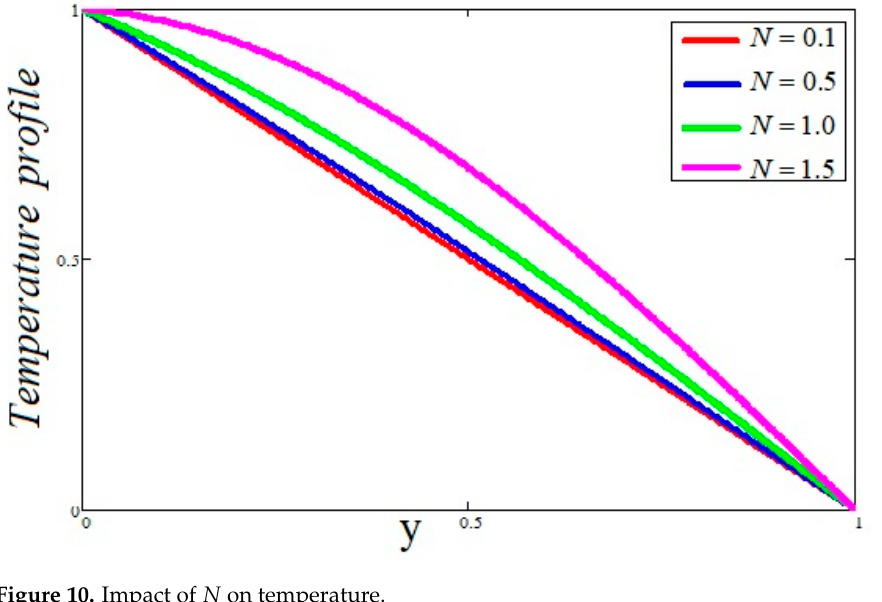
Figure 10. Impact of N on temperature.